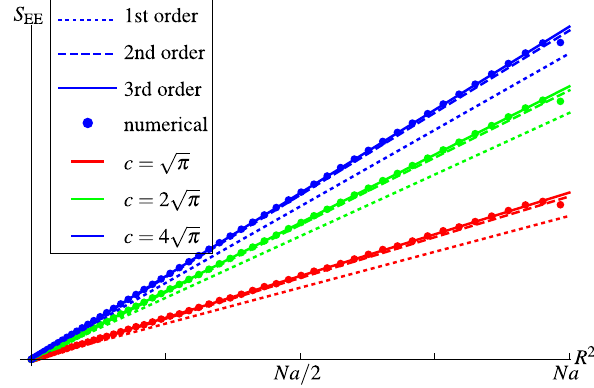
Fig. 5 The entanglement entropy in scalar field theory in 3 + 1 dimen- sions with an azimuthal cutoff of the form (cid:10) max = cR / a for ma = 1 and various values of the constant